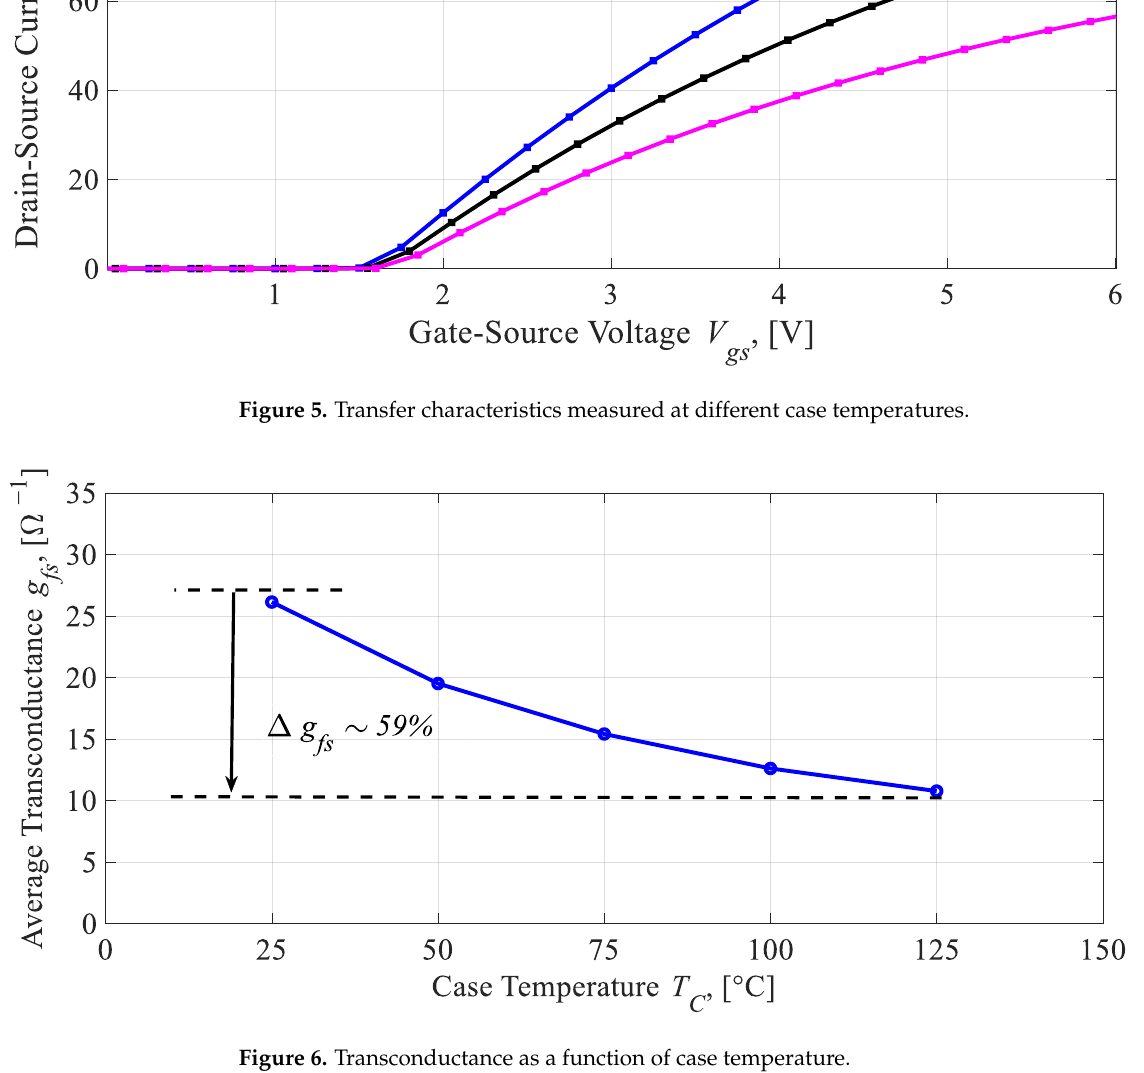
Figure 6. Transconductance as a function of case